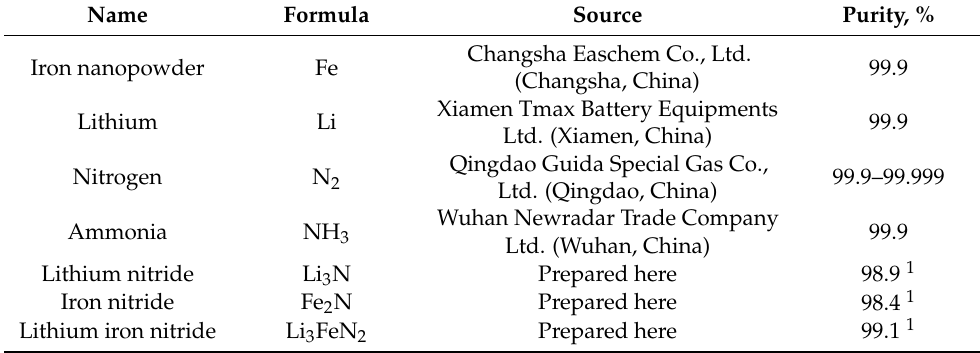
Table 1. Summary of chemicals